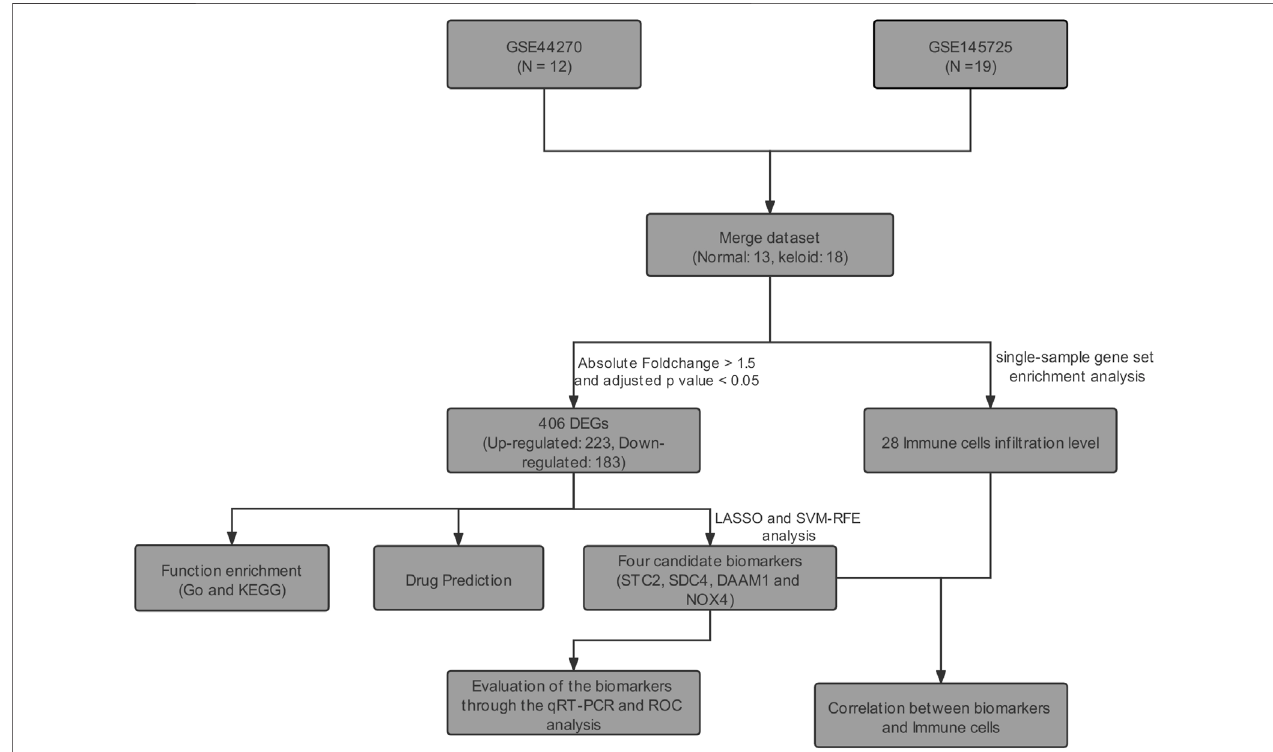
FIGURE 1 | Flowchart of this study ’ s analysis